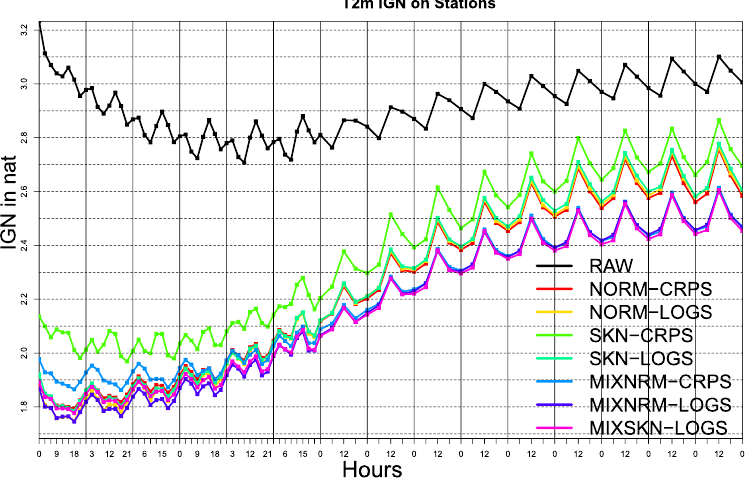
Figure 6. Average LogS on 3 years/2056 stations along lead times. The ranking of the forecasts is very similar to Figure 4. The RAW ensemble seems to gain predictive performance until Day